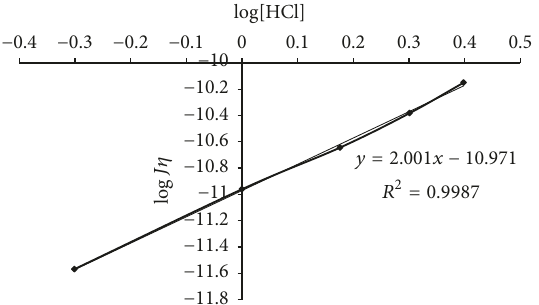
Figure 5: Plot of log [ HCl ] versus log 𝐽𝜂 (same operating conditions as given in Figure 4).